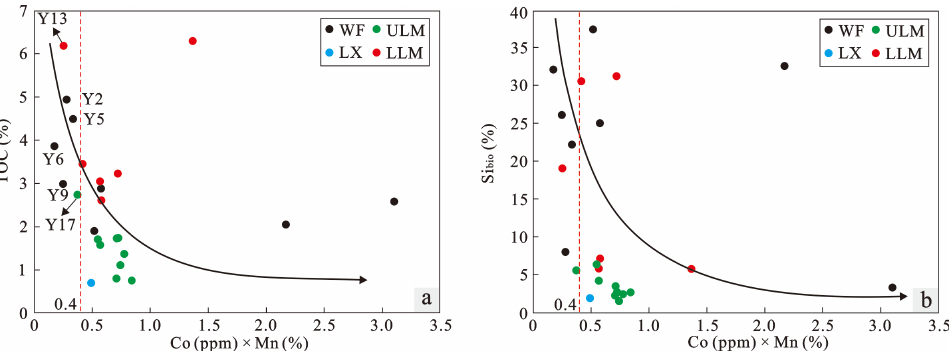
Figure 12. ( a ) Crossplots of TOC content vs . Co × Mn values and ( b ) crossplots of Si bio content vs . Co × Mn values indicating that the WF showed much stronger upwelling and a negative correlation between palaeoproductivity and upwelling intensity, implying that strong upwelling could bring nutrients from the deep ocean to the shallow shelf, leading to high palaeoproductivity.